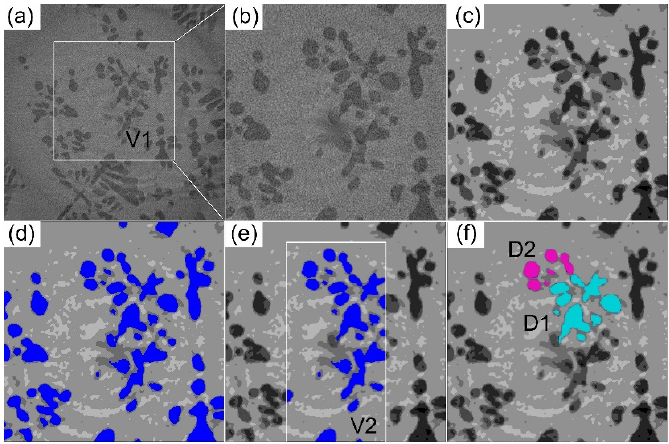
4 of 18 Figure 1. ( a ) A schematic illustration of the experimental setup. ( b ) The measured temperature profiles of TC1, TC2, TC3, and TC4 during the solidification experiments. The framed area is the period during which tomography scans were performed. During experiments, the two furnaces were firstly heated up to ~700 °C to melt the alloy completely. The temperature of the top and bottom furnaces was then simultane- ously decreased until the sample temperature (showed by the readings from TC3 and TC4) reached ~610 °C (Figure 1b). After this, the temperature was maintained, and tomog- raphy scans started. A polychromatic X-ray beam filtered to 50% power and a pco.edge 5.5 detector (PCO AG, Kelheim, Germany) with a 100 μ m thick LAG:Ce scintillator were used. Sample-to-detector distance was set to 300 mm. A 10× magnification objective lens was used, resulting in a pixel size of 0.65 μ m with a field of view of 2016 × 2016 pixels (equivalent to ~1.31 × 1.31 m 2 ), which is able to contain sufficient number of dendrites for statistical analyses. Five hundred projections were acquired in an angular step of 0.36° over a 180° rotation, each with an exposure time of 7 ms. Hence, one tomography scan was completed in 3.5 s, and the skip time between two continuous scans was 10 s. The scans were taken continuously for about 6.7 min (see the framed region in Figure 1b). 2.3. Image Processing The 16-bit raw tomography datasets were firstly binned and converted into 8-bit im-